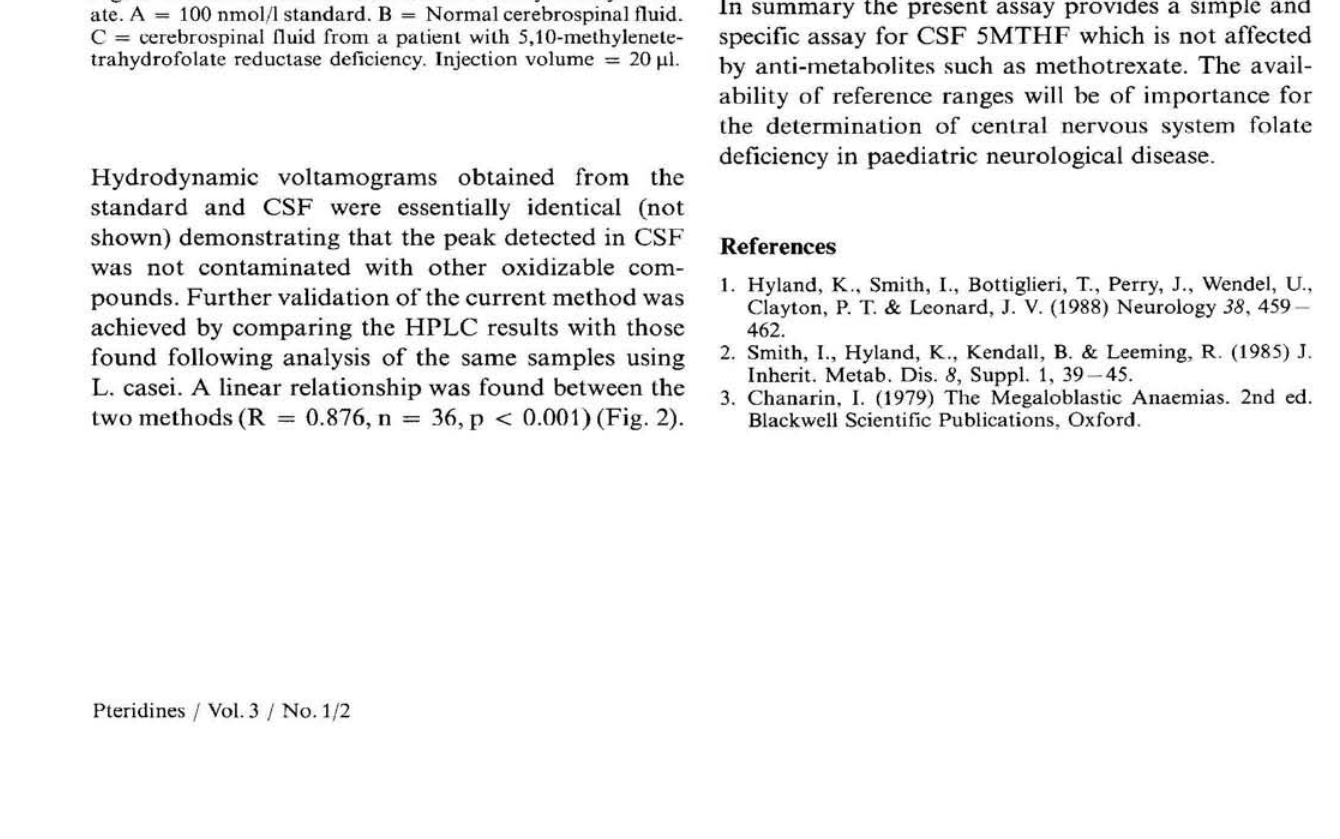
Figure 2. Comparison of HPLC assay for 5-methyltetrahydro- folate with L. casei assay for total folate. A reference range was established using a paediatric population having various neurological diseases. Ex- cluded from this group were patients: a) having signs of CNS infection, b) with indication of altered one carbon metabolism, c) taking anticonvulsant medi- cation d) with inborn errors affecting folate or pterin metabolism or e) those having abnormal biogenic amine metabolism or movement disorders. Reference values ranged from 39.7 nmol/1 to 174 nmol/1. The mean (+ 95% confidence interval) for selected age groups (years) were as